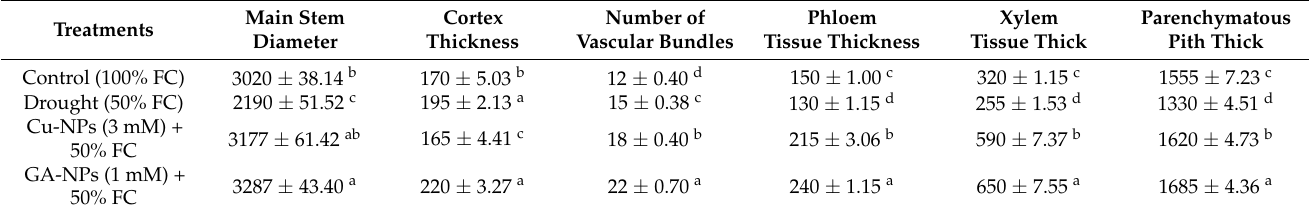
Table 3. The effect of Cu-NPs (3 mM) and GAS-NPs (1 mM) on anatomical characters of soybean stem ( µ m) under drought stress (50%